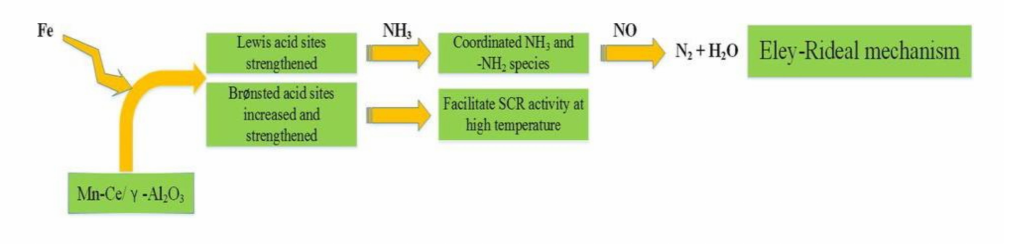
Figure 7. The reaction flow chart of Fe–Mn–Ce / γ -Al 2 O 3 catalyst